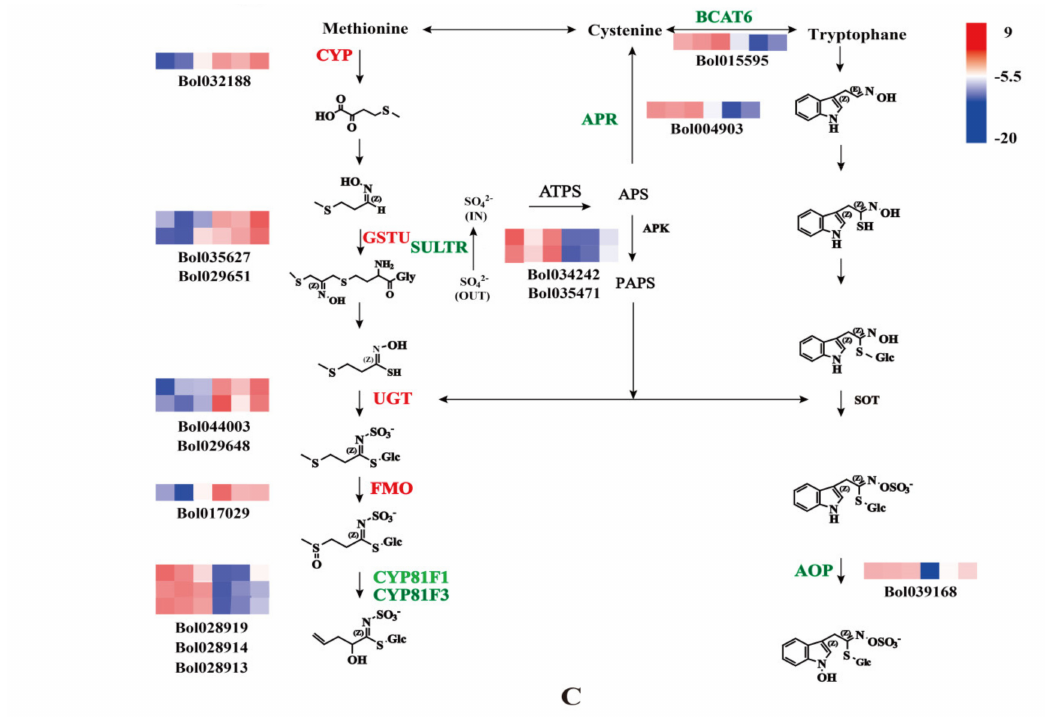
Figure 3. Heat maps depicting the normalized gene expression values, which represent the means ± SD of three biological replicates. Expression values are presented as Fragments Per Kilobase of transcript per Million mapped read (FPKM) normalized log2-transformed counts. ( A ) Heat map of differentially expressed genes (DEGs) involved in the biosynthesis of amino acids. ( B ) Heat map of DEGs involved in the plant hormone signal transduction. ( C ) Heat map of DEGs involved in the synthesis of glucosinolates (GLS). The first three squares of the heat map represent three repetitions of the − S process, and the last three squares represent three repetitions of the +S process. The six genes that regulate Amino acid synthesis are Bol010243(SAT3), new Gene_1790(TSB), Bol037698(METK3), Bol042574(AGT1), Bol023108(OMR1), Bol024117(ADT1). The eight genes that regulate hormone synthesis are Bol018356(IAA3), Bol040881(ERS2), Bol006843(IAA4),